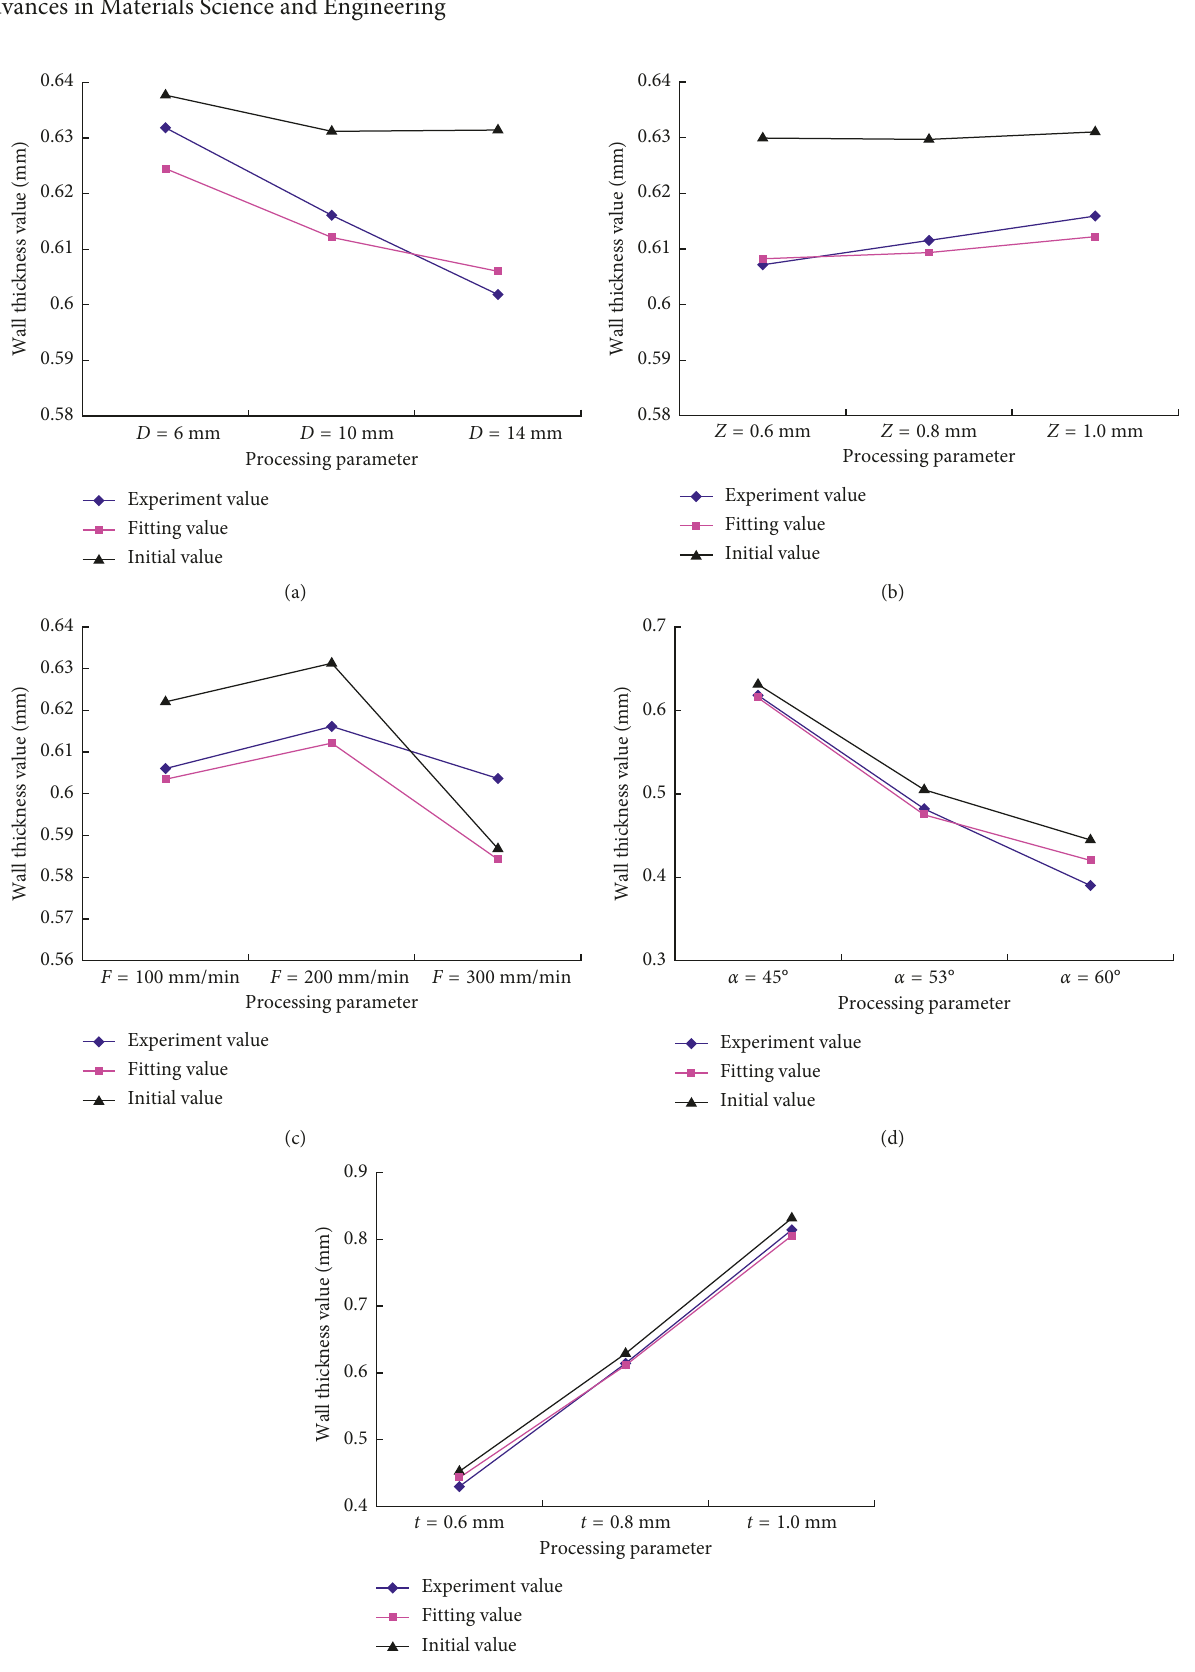
Figure 10: Comparisons between the theoretical and experimental results. (a) The wall thickness values under different tool diameters, (b) the wall thickness values under different step down values, (c) the wall thickness values under different feed speeds, (d) the wall thickness values under different forming angles, and (e) the wall thickness values under different initial thickness